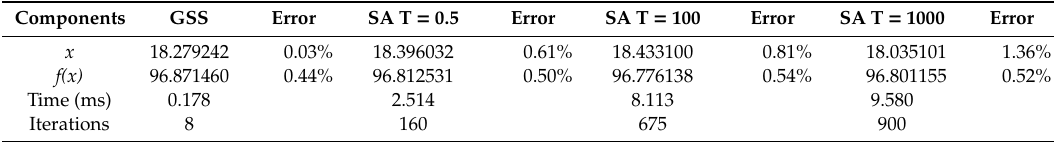
Table 4. Results of the algorithms for the test function